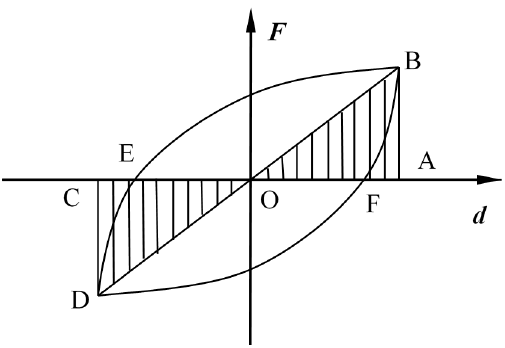
Figure 22. Schematic diagram of calculation for the equivalent viscosity damping coefficient.